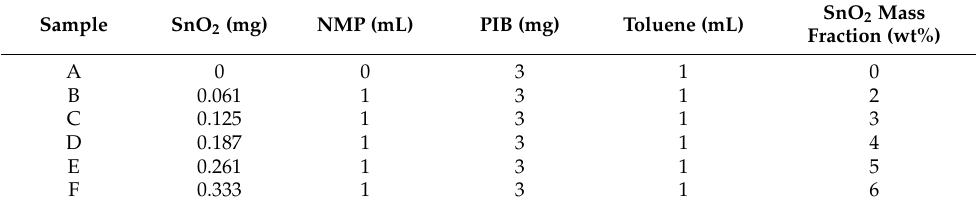
Table 1. Different proportions of PIB: SnO 2 NPs composite